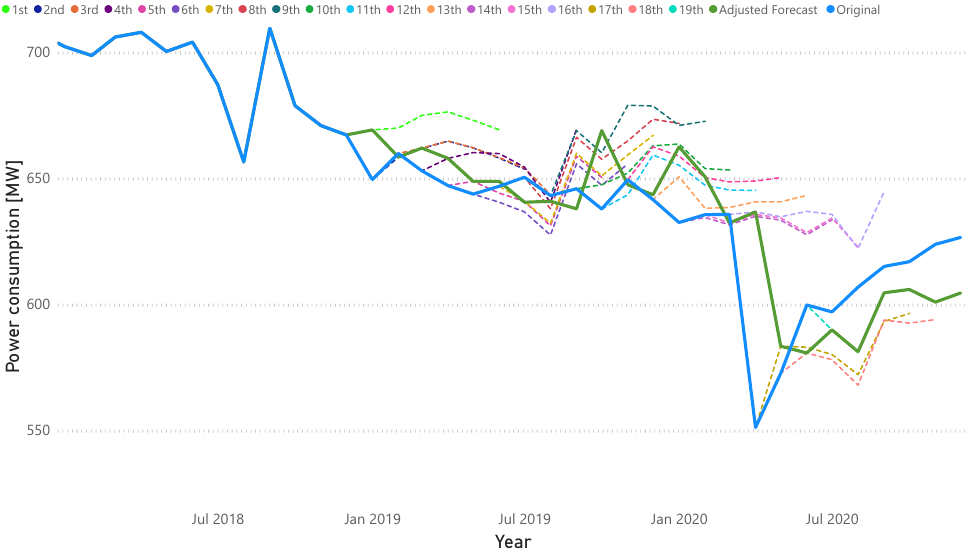
Figure 11. Adaptive forecast process generated for 24